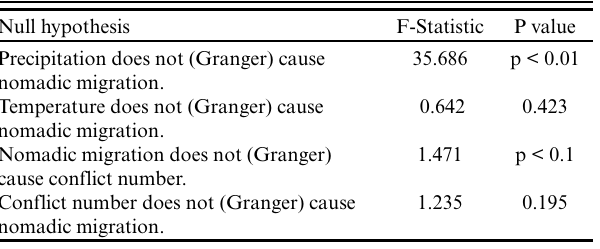
Table 3 . Granger causality analysis of “climate change → nomadic migration → conflicts between pastoralists and